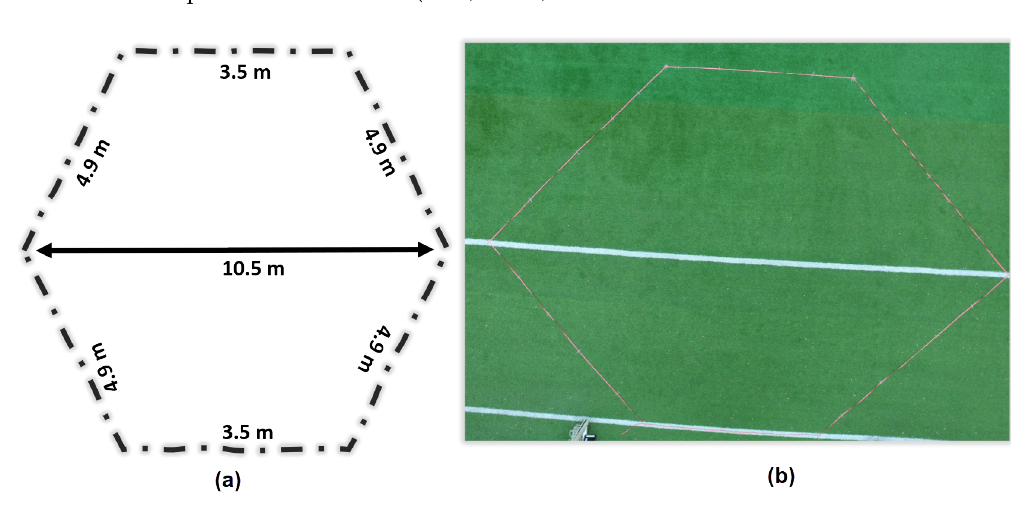
Figure 5. Experiment 2: ( a ) Conceptual; ( b ) Physical